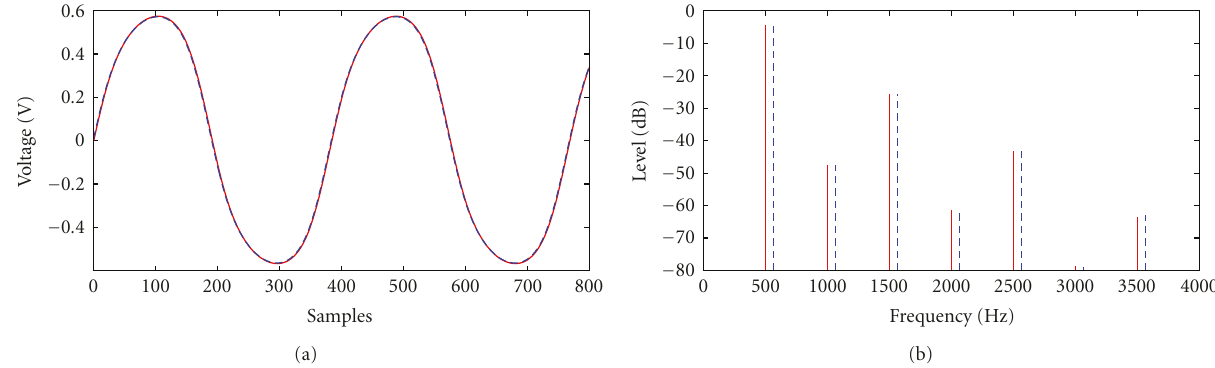
Figure 8: Comparison between the real-world output of pedal 1 (blue-dashed) and the GPH model-based output (red-solid) in time (a) and frequency (b) domains, for a sine wave excitation with f 0 = 500 Hz and A 0 = 0 . 5 V. The GPH model is estimated using a swept sine signal with amplitude A s = 0 . 5 V. For the sake of clarity, the output of the real-world device in the frequency domain is shifted to the